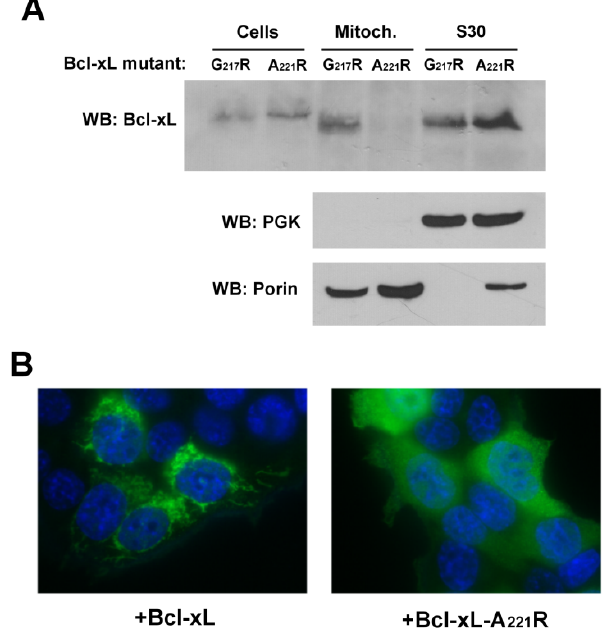
FIGURE 2: Characterization of a cytosolic mutant of Bcl-xL. (A) Lo- calization of two mutants of Bcl-xL carrying single substitutions in the C-terminal α-helix, following their expression in yeast. The mu- tant A221R was excluded from the mitochondrial fraction, opposite to the mutant G217R. (B) Localization of wild-type and A221R mu- tant of Bcl-xL in HeLa cells. Cells were transfected with Bcl-xL- expressing plasmids and Bcl-xL was detected by immunofluores- cence as described previously [35]. Nuclei were counter-stained with DAPI. The mutant A221R displayed a diffuse cytosolic localization, opposite to the